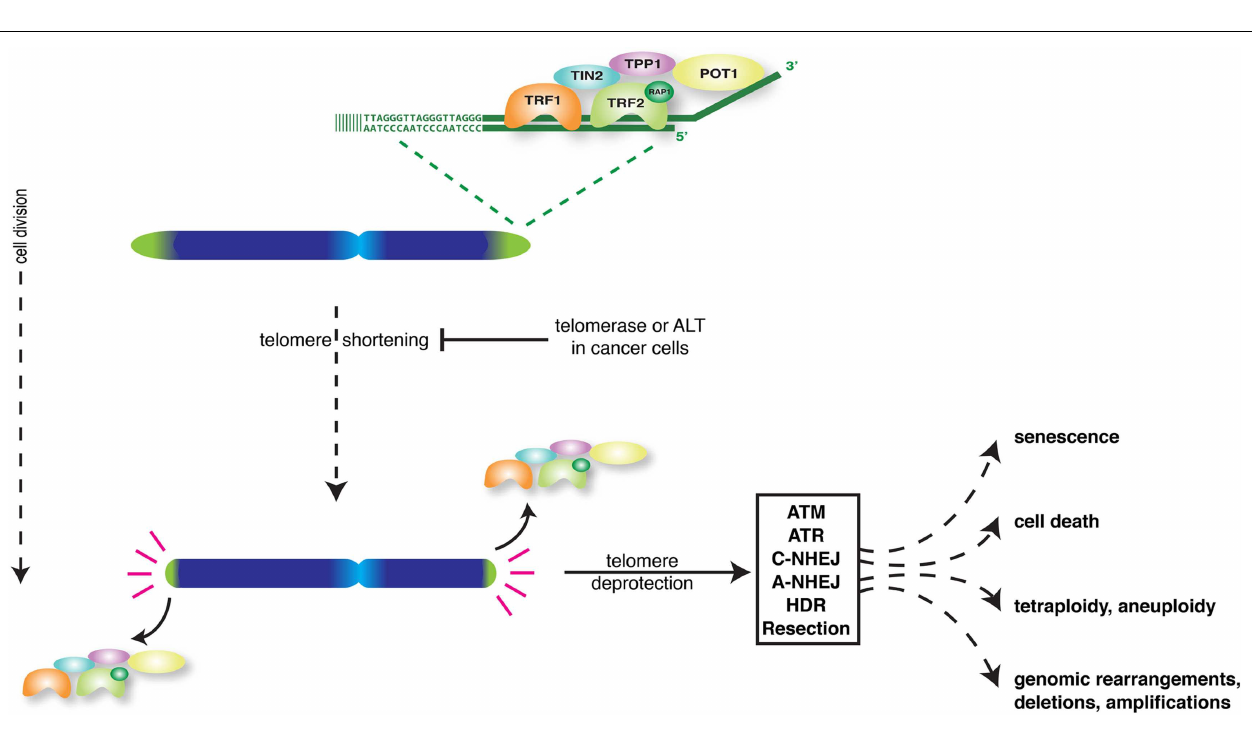
FIGURE 1 | Overview of the major consequences of loss of telomere protection in mammalian